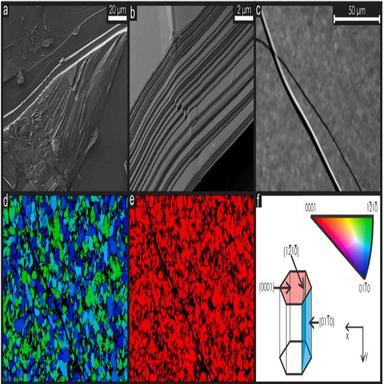
SEM micrographs and EBSD data of an HOPG sample: (a) surface of the sample, (b) edge of the sample showing the laminar structure of HOPG graphite, (c) FSD image of HOPG graphite, (d) EBSD inverse pole figure map in the x-direction, (e) inverse pole figure map in the z-direction, (f) inverse pole figure notation and corresponding planes on the crystal structure of graphite.